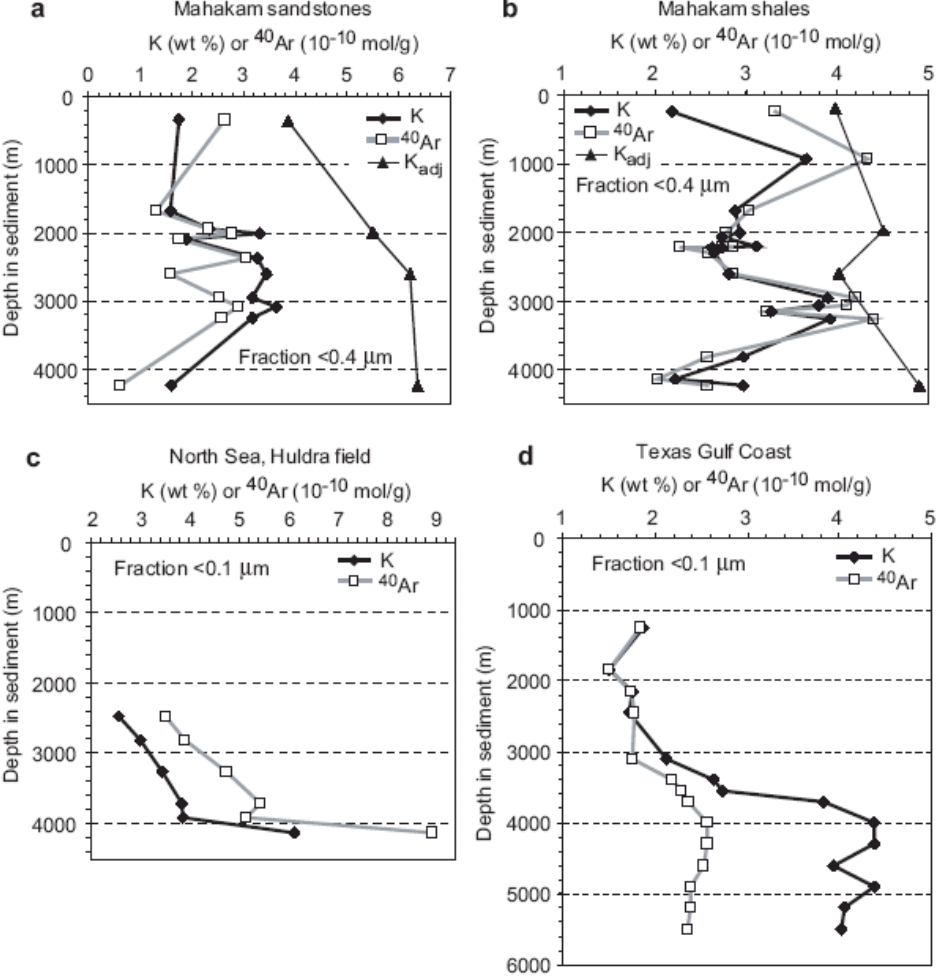
Figure 1. Potassium (K in wt.%) and radiogenic 40 Ar (10 − 10 in mol/g) contents of the fine-grained clay fractions in: ( a ) the sandstone of the Mahakam Delta Basin; ( b ) shale sections of the Mahakam Delta Basin [36]; ( c ) the section in the North Sea, Bergen High area [22]; ( d ) the section in the Texas Gulf Coast [37]. In ( a , b ), K is the concentration in the whole <0.4 µ m fraction, K adj is the concentration only in the K-bearing mineral phases illite and I-S of the same <0.4 µ m fraction [24]. Note the differences in the horizontal scale of the figures.